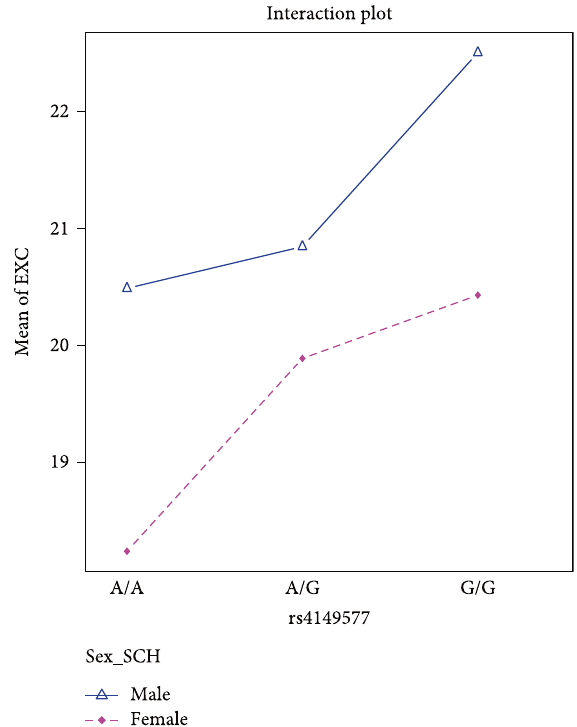
Figure 1: The results of the ANOVA analysis for rs4149577 and EXC subscale in the patient